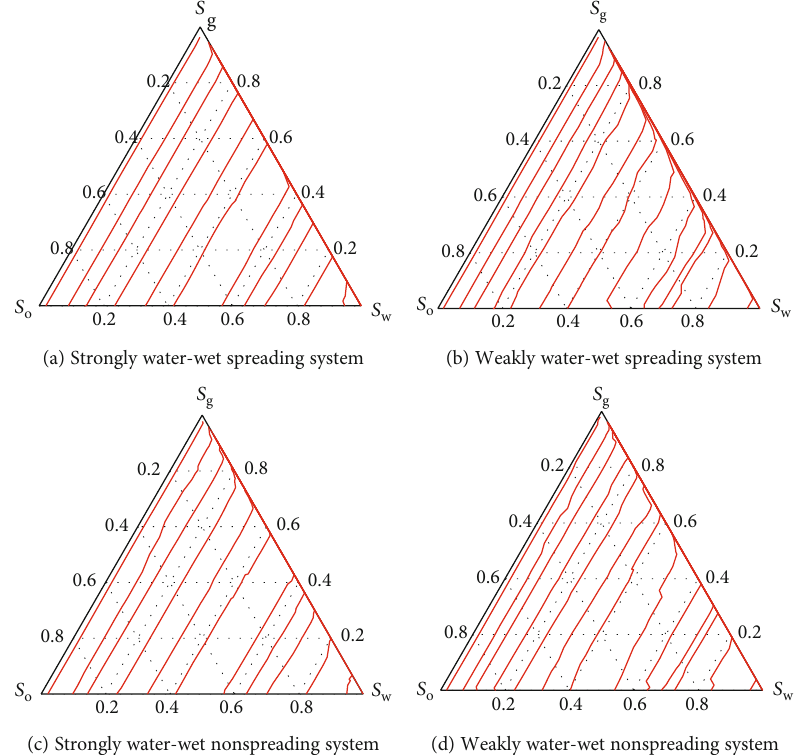
Figure 12: Computed phase saturation paths for gas invasion in an oil-water- fi lled segmented SEM image of Bentheim